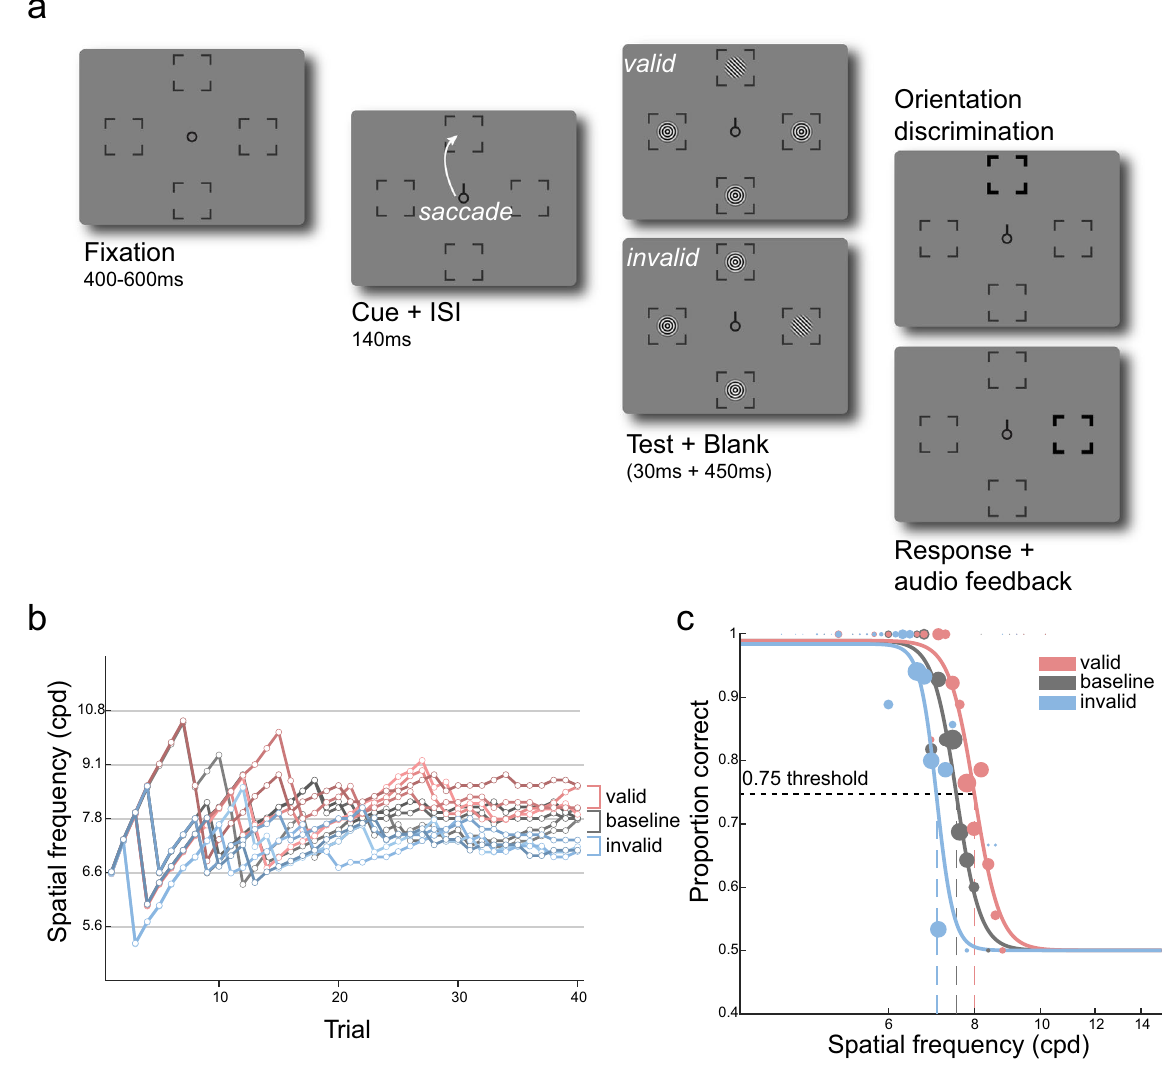
Figure 1. Experimental design (a) Trial sequence for eye movement blocks. After a fixation period, a central saccade cue indicated the saccade target. Participants were instructed to make a saccade to the center of the corresponding placeholder as soon as the cue appeared. Just before saccade onset, one test Gabor stimulus and three radial frequency pattern distractors were presented briefly. The test Gabor could appear at the cued ( valid ) or at one of the un-cued ( invalid ) locations. After a delay, a boldened placeholder indicated the location at which the test Gabor was presented, and participants judged its orientation (CW or CCW). The spatial frequency of the test and the matching distractors was varied based on Bayesian adaptive procedures aimed at finding the 75% acuity threshold (Fig. 1b). In the fixation blocks ( baseline ; not illustrated here), the trial sequence was identical except that the cue pointed to all four locations, and participants were instructed to fixate at the center throughout the entire block. (b) Adaptive staircases for a representative participant for one location. For each location, we ran four independent staircases per condition ( valid , baseline , and invalid ). The estimated 75% thresholds for the staircases were averaged to derive the final acuity thresholds. (c) The responses from